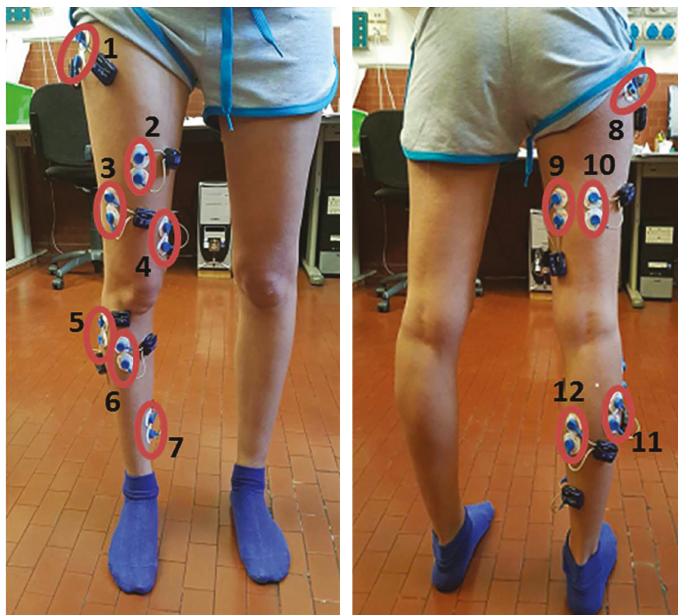
Figure 1: Muscles recorded during the experimental protocol from the dominant leg of each subject: example of electrode placement. 1: tensor fasciae latae (TFL); 2: rectus femoris (REF); 3: vastus lateralis (VLAT); 4: vastus medialis (VMED); 5: peroneus longus (PERO); 6: tibialis anterior (TA); 7: soleus (SOL); 8: gluteus maximus (GLU); 9: semitendinosus (SEMT); 10: biceps femoris (BIF); 11: gastrocnemius lateralis (LGAS); 12: gastrocnemius medialis